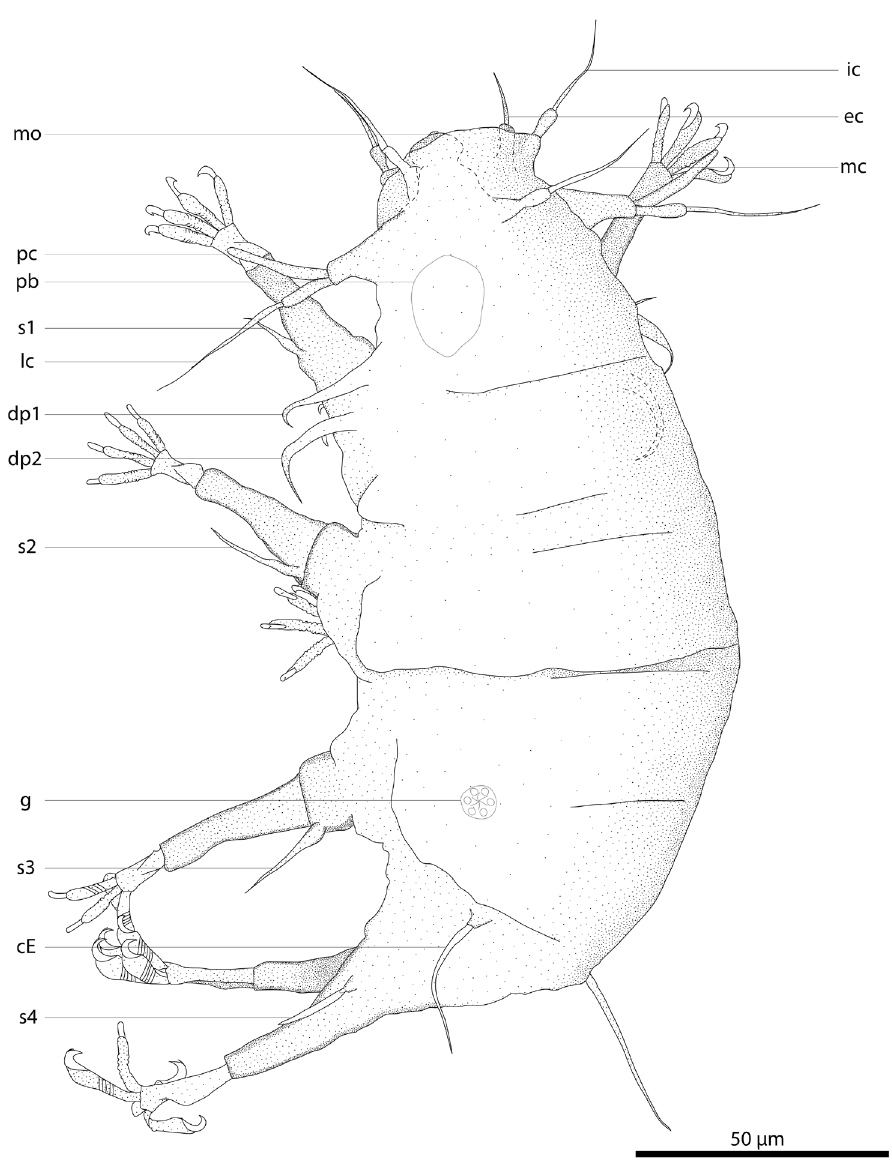
Figure 6. Drawing of Halechiniscus yanakaagii sp. n., holotype KUZ Z712 (dorso-lateral view). cE cirrus E; dp1–2 anterior and posterior double processes; ec external cirrus; g gonopore; ic internal cirrus; lc lateral cirrus; mc median cirrus; mo mouth; pb pharyngeal bulb; pc primary clava; s1–4 leg I–IV sense organs.